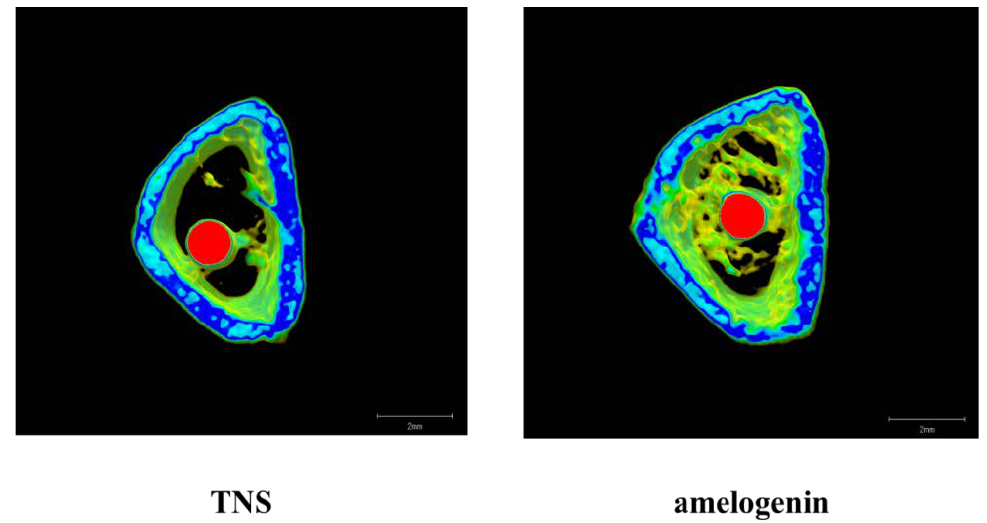
Figure 12. Micro-CT images (The implants were marked with red color, cortical bone with blue color, and cancellous bone with green color).